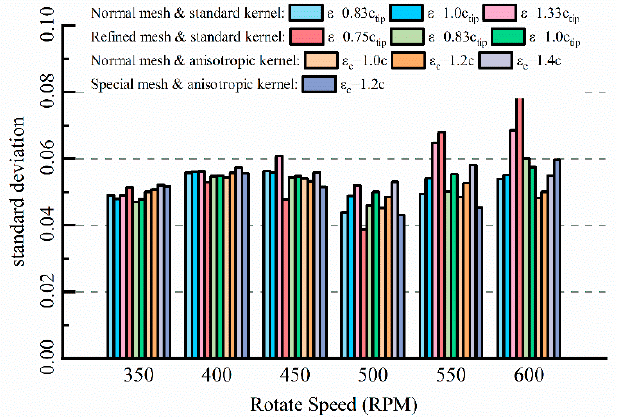
Figure 17. Standard deviation of the velocity magnitude in the plane perpendicular to the main flow direction.